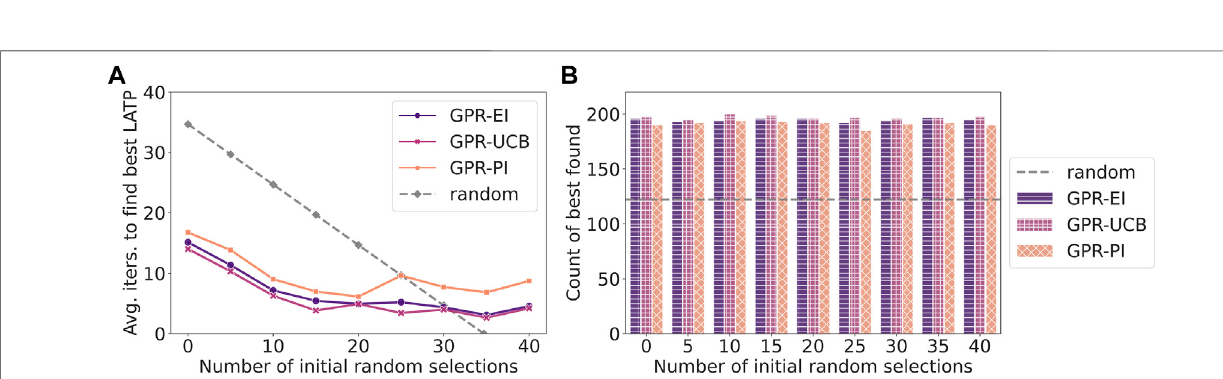
FIGURE 3 | Comparison of GPR based Bayesian optimization with different acquisition functions, EI (dark purple), UCB (light purple), PI (orange) and random selection (grey dashed): (A) number of counts to fi nd the global maximum in the repeated 200 virtual experiments, where random selection (grey dashed line) can fi nd 126 times (63 % ); (B) number of additional tries of different strategies needed after n initial random selections (x-axis) to fi nd the global maximum of ionic conductivity (1.09 × 10 − 3 S cm − 1 ) in the training data set (grid search). On average random selection takes about 34.7 tries to arrive at the maximum. It is noticeable that only those cases where the global minimum is found are counted to calculate the